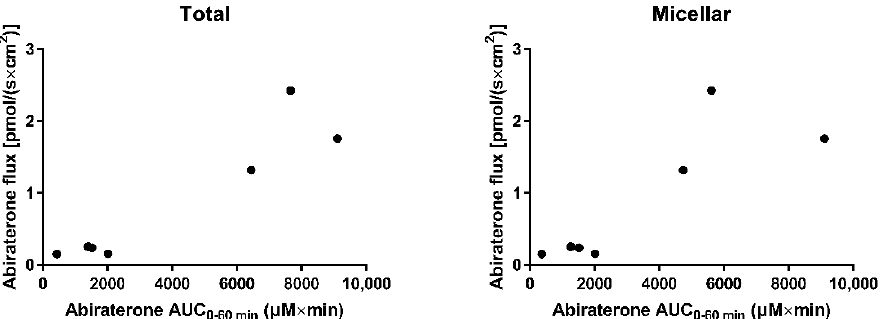
Figure 7. Correlation between the abiraterone flux towards the mesenteric vein and abiraterone AUC 0–60min obtained from the concentration-time profiles of the perfusate in FaSSIF, FeSSIF*, FeSSIF*-FM, FeSSIF*-FMT, FeSSIF*-FMT h , FeSSIF*-T h and FeSSIF*-E. Left : total concentrations, right : micellar concentrations.